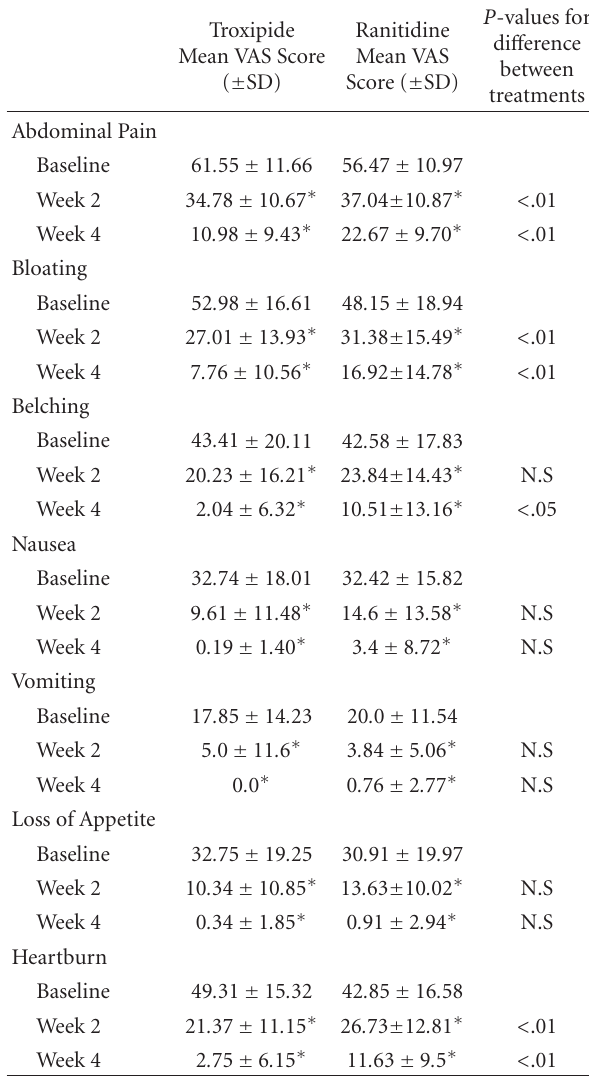
Table 2: Mean four-point scale (FPS) scores for signs of endoscopic Gastritis in patients at baseline and week 4.